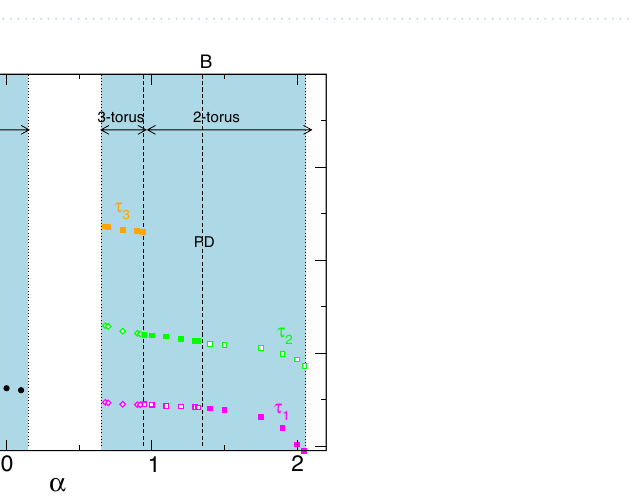
Figure 13. Spacetime plot of u for pV 2 at ( 1 ) α are shown for three different radial positions, (a) r yellow (light gray) correspond to positive and negative values, respectively (see Fig. 7).